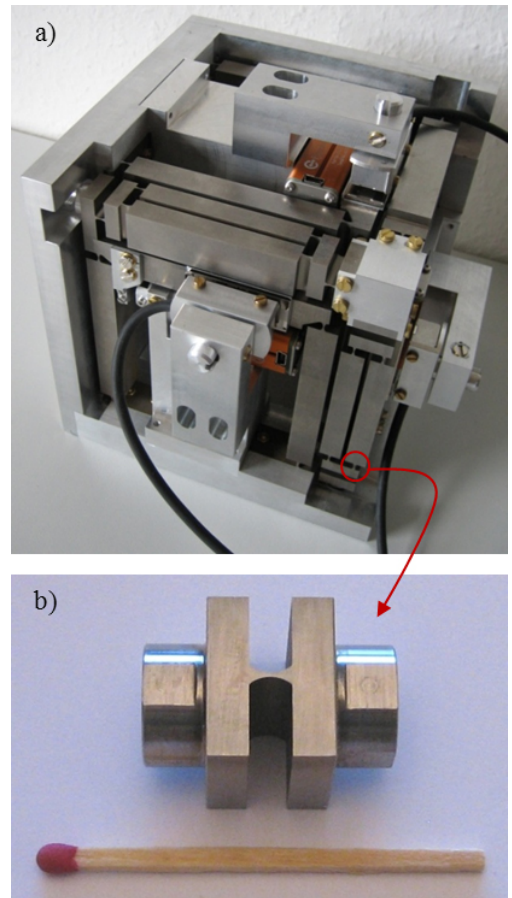
Figure 1. (a) High-precision micro manipulator (working space: ± 2.15 ×± 2.15 ×± 2.15mm 3 , resolution: 0.1µm) developed at the Department of Mechanism Theory and Dynamics of Machines of RWTH Aachen University (Ivanov and Corves, 2014). (b) Flexure hinge specimens fabricated by electro-discharge machining from Ti-6Al-4V grade 5 (annealed bar) at KAPE Erodiertechnik (KAPE,